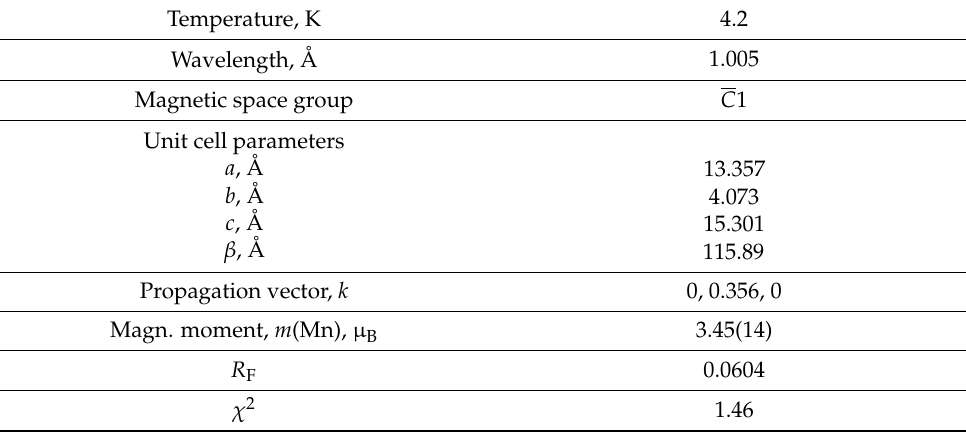
Figure 4. ( a ) A view of the magnetic structure of MnBi 2 Se 4 down the b axis, emphasizing the rotation angle of 128° between the adjacent magnetic moments. The numbers refer to the sequence of moments rotating around the b axis. ( b ) A side view of chains of helically ordered magnetic moments. Table 1. Details of the magnetic structure refinement parameters for MnBi 2 Se 4 .